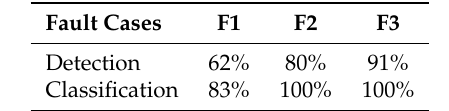
Table 3. Random sample test: Fault detection and classification